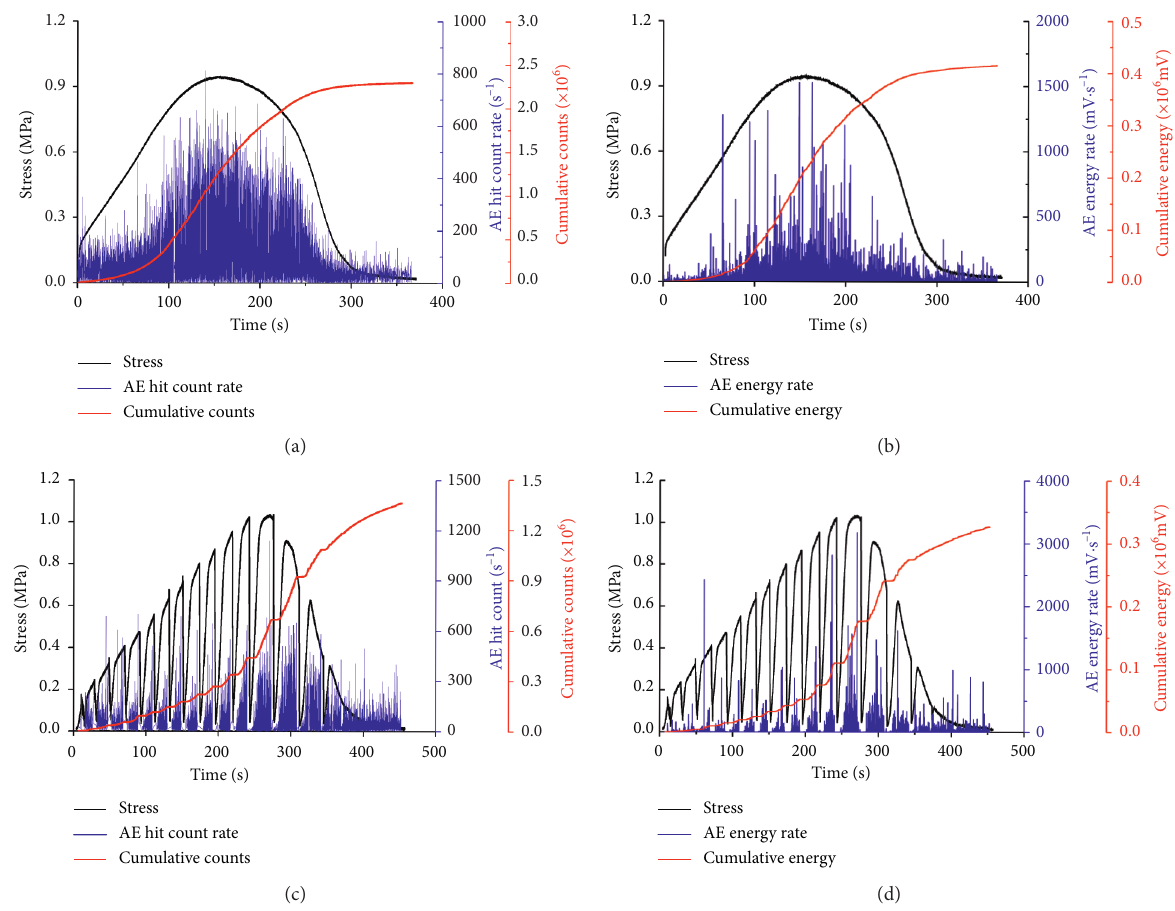
Figure 4: Stress-time, AE characteristic parameters-time curves of salt rock. (a) AE hit count of specimen d-1. (b) AE energy of specimen d-1. (c) AE hit count of specimen f-1. (d) AE energy of specimen